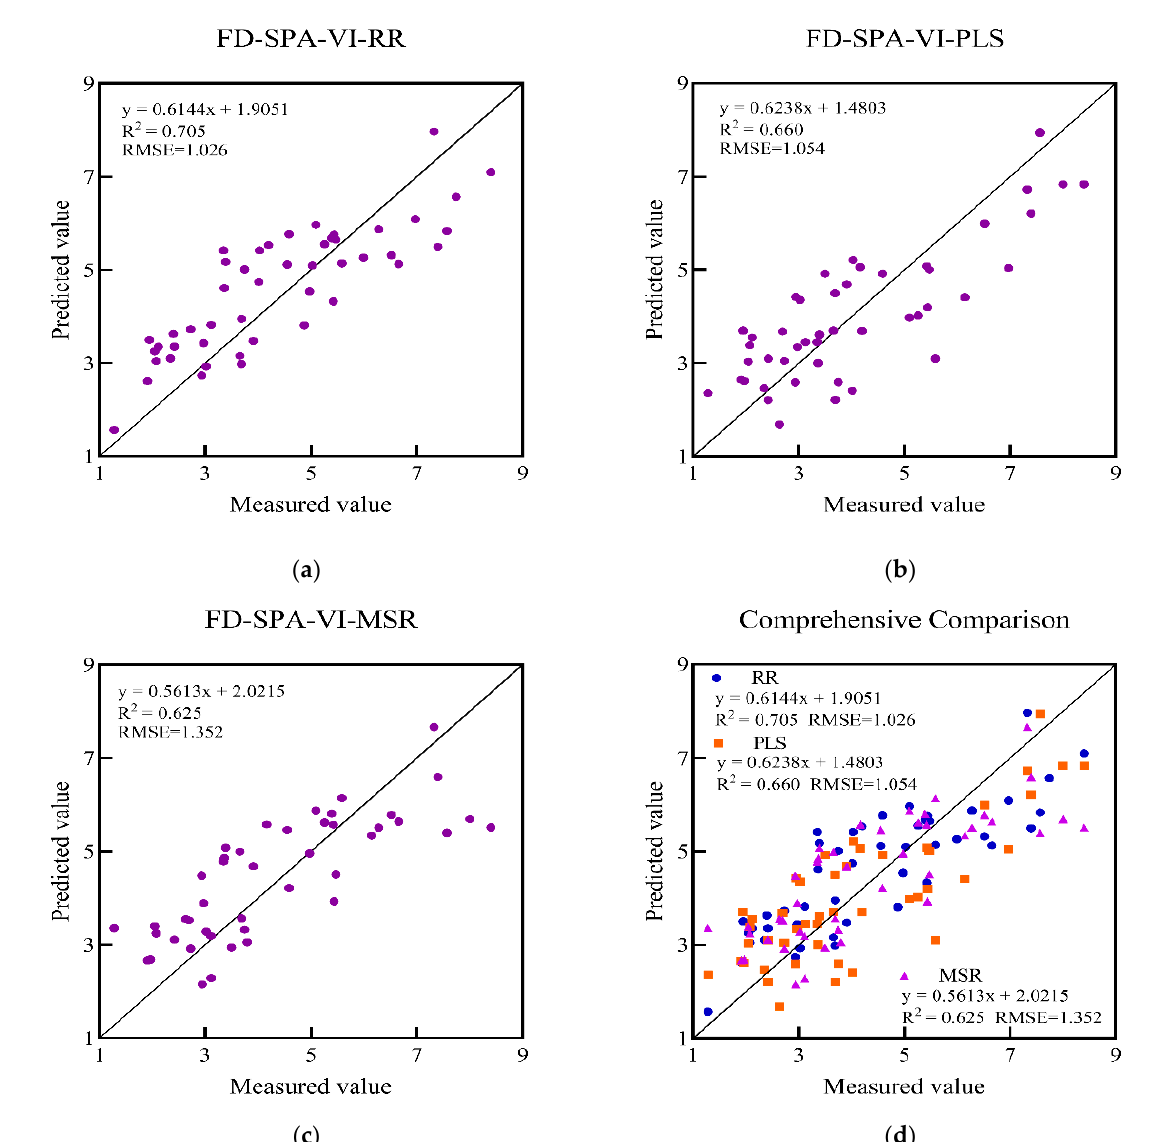
Figure 8. Evaluation results of the modeling method based on the validation set 2. ( a ) SPA-VI-RR model; ( b ) SPA-VI-PLS model; ( c ) SPA-VI-MSR model; ( d ) comprehensive comparison of three models. The validation LAI sample size was 45.